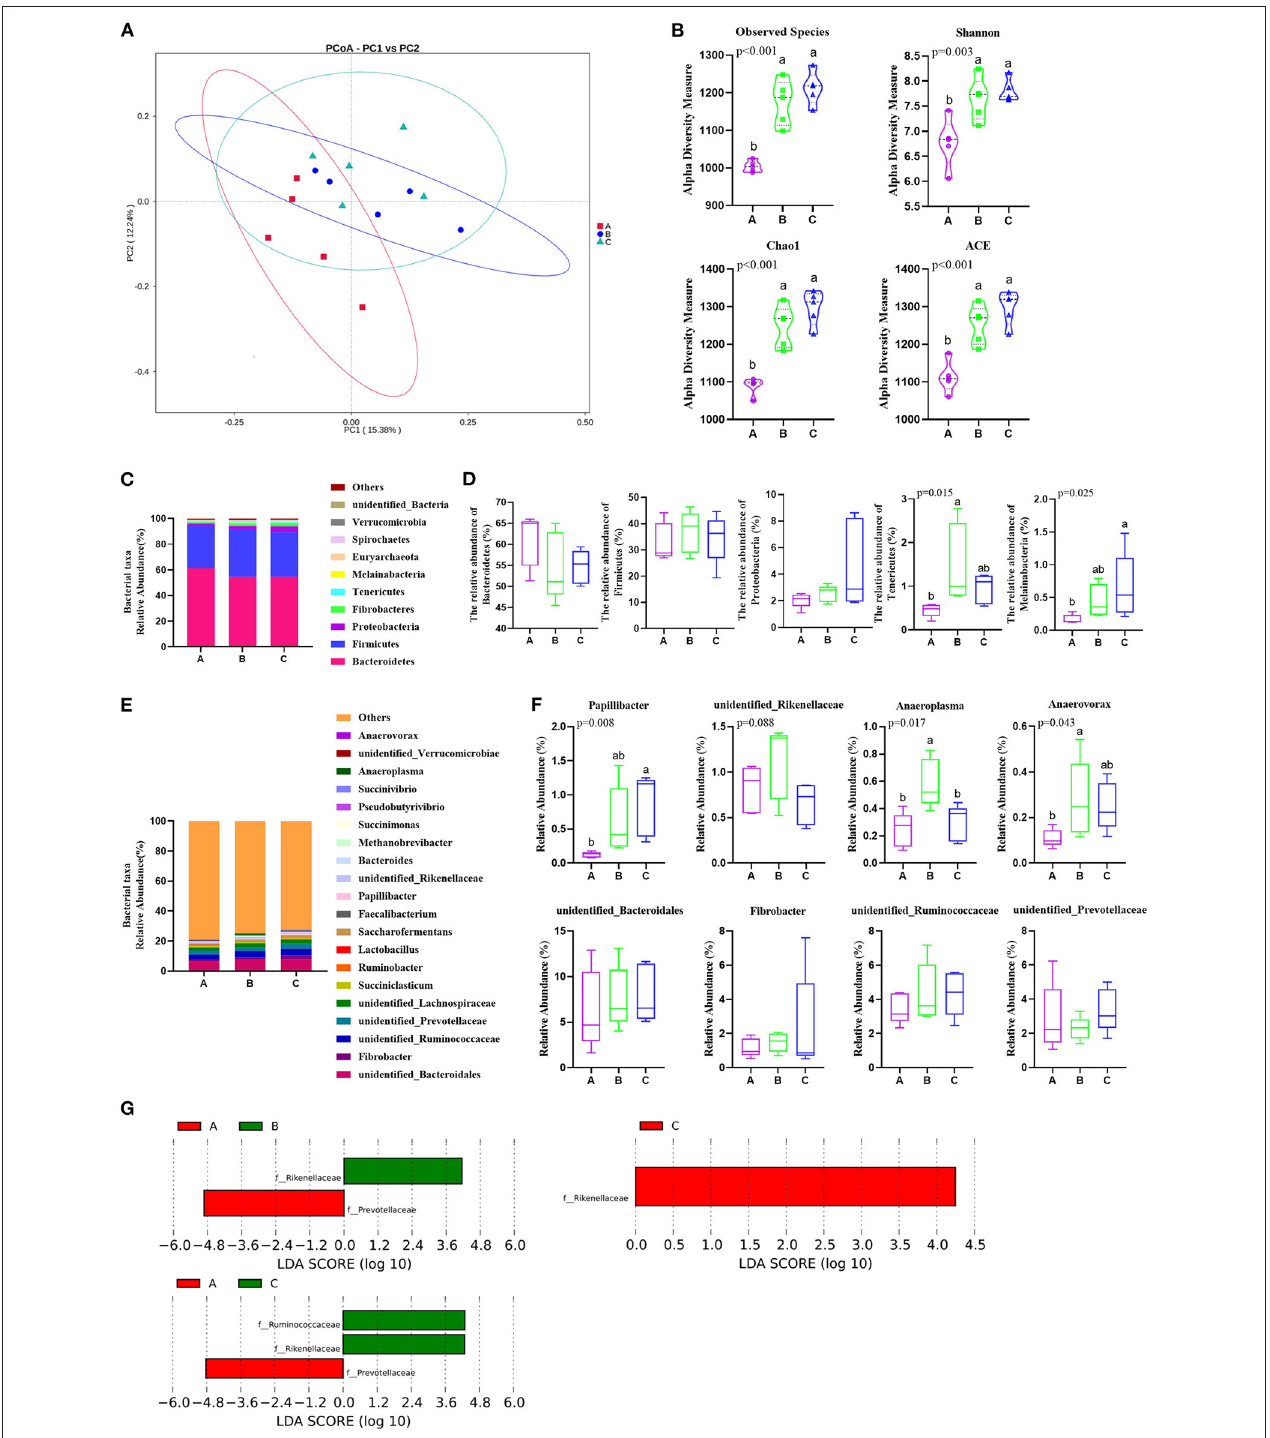
FIGURE 1 | Phragmites australis shoot remainder (PSR) silage totally or partially substituting the corn silage alters rumen microbiota composition in Angus beef cattle ( N = 5). Group A, fed 60% PSR silage; Group B, fed 30% PSR silage + 30% corn silage; and Group C, fed 60% corn silage. (A) PCoA analysis of rumen microbiota based on operational taxonomic unit (OTU) abundance. (B) Assessment of alpha diversity. (C) Rumen microbiota taxonomic profiling at the phylum level. (D) Relative abundances of Bacteroidetes, Firmicutes, Proteobacteria, Tenericutes, and Melainabacteria. Bars with different letters (a, b) indicate significant differences ( p < 0.05) among different groups (the same below). (E) Rumen microbiota taxonomic profiling at the genus level. (F) Relative abundances of representative and significant difference genera. (G) LDA score of rumen microbiota composition according to LEfSe analysis by three treatments.